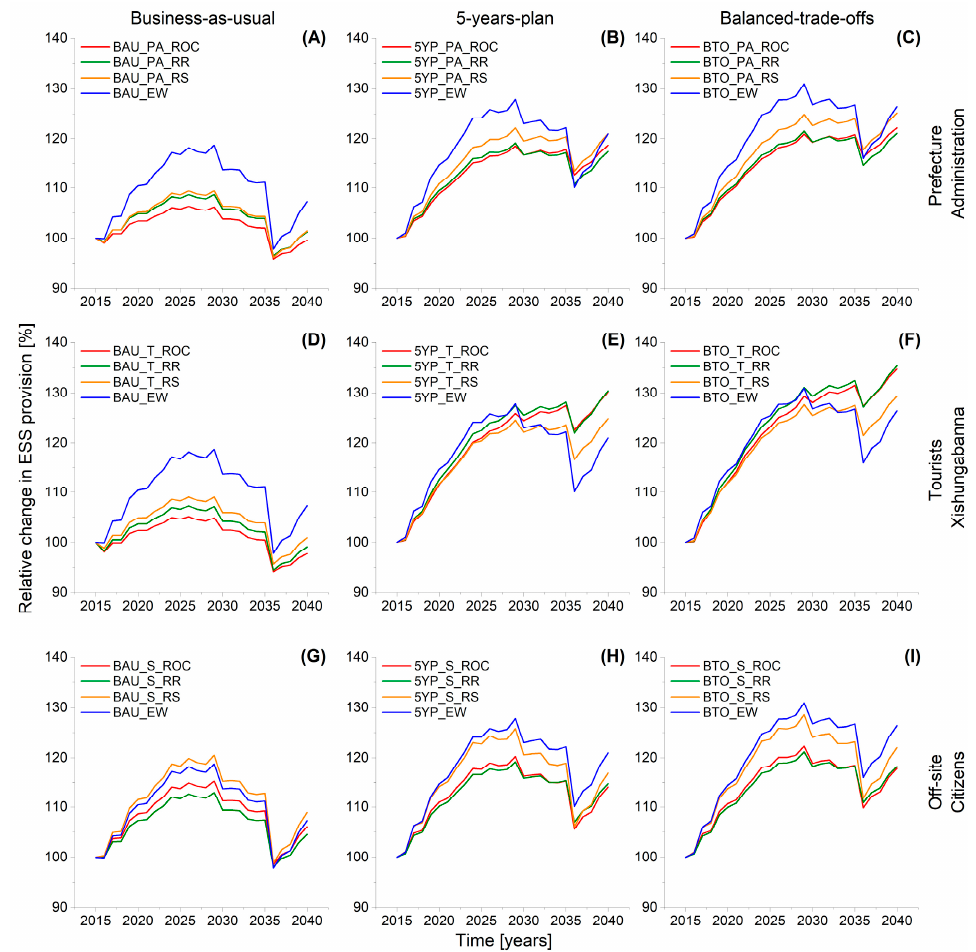
Figure 4. Changes in integrated ESS provision relative to the initial state of 2015. Each graph contains time series corresponding to the scenario (BAU: Business-as-usual ( A,D,G ); 5YP: 5-years-plan ( B,E,H ); BTO: Balanced-trade-offs ( C,F,I ) and stakeholder group ranking (Prefecture Administration ( A,B,C ), Tourists Xishuangbanna ( D,E,F ), Off-site Citizens ( G,H,I ), as well as the statistical weighting method (ROC: centroid weights, RR: inverse weights, RS: rank sum; EW: equal weights).